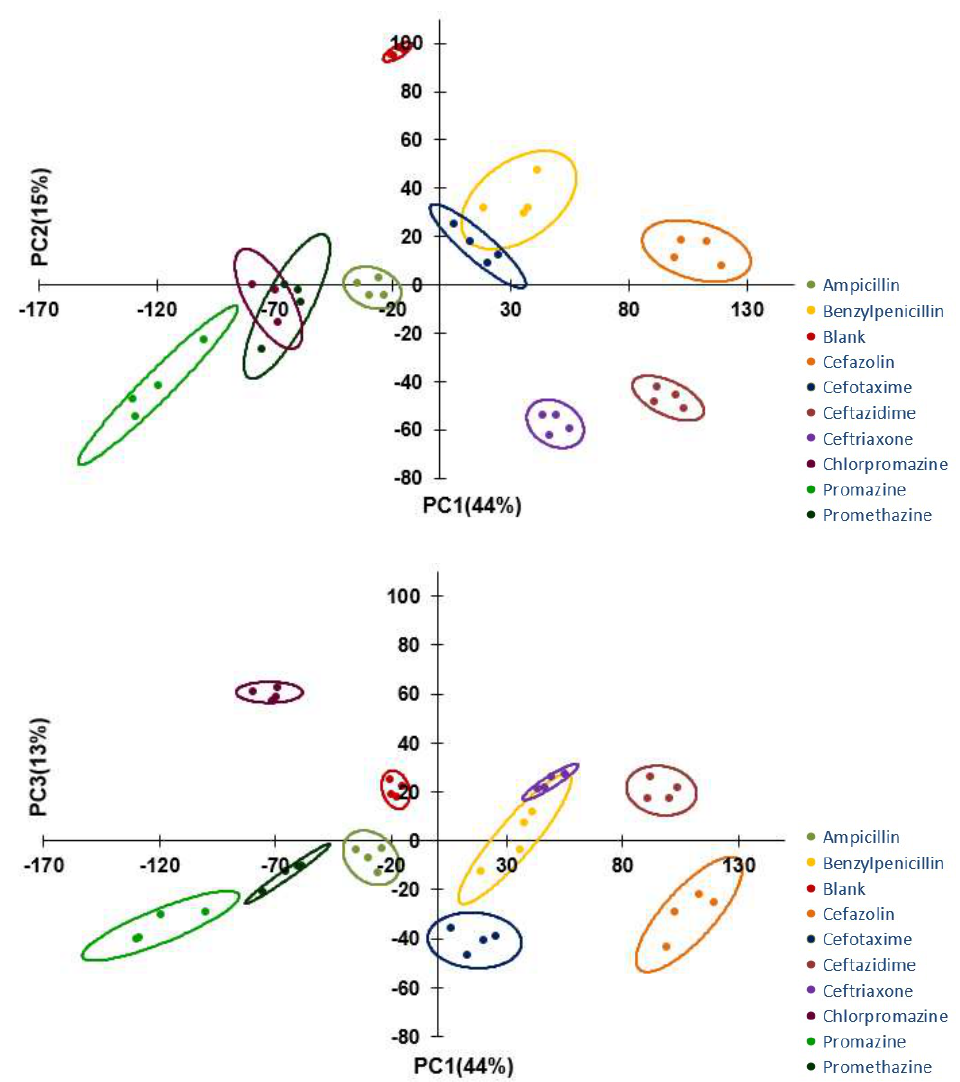
Figure 5. Score plots obtained with the basic dataset in the coordinates of first and second ( top ) and first and third ( bottom ) principal components.